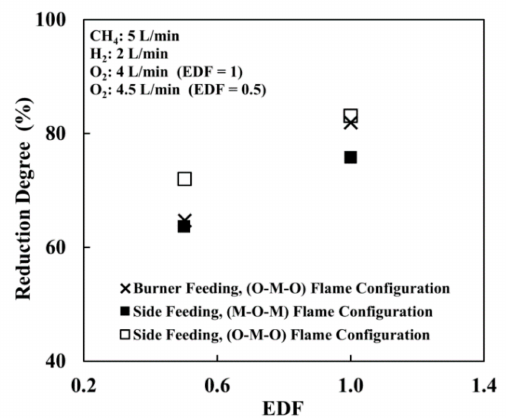
Figure 11. E ff ect of EDF on reduction with di ff erent feeding modes and flame arrangements. (The figure is adapted from Sohn et al.